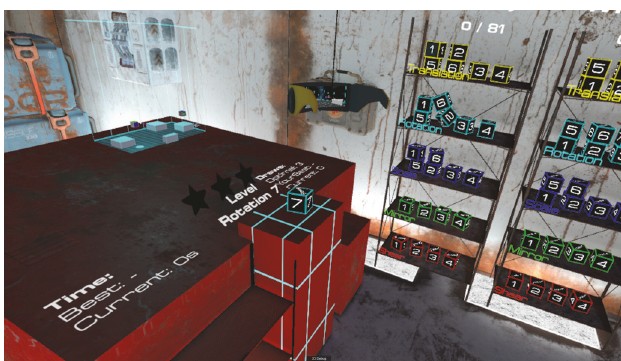
Figure 10: GEtiT VR realizes the game’s menu as a playing room. The Virtual HMD allows for a transition between the menu and a